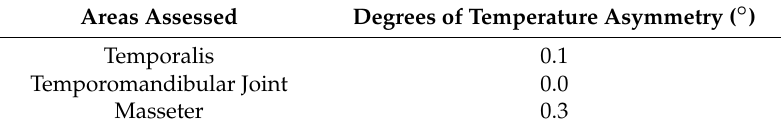
Table 2. Infrared imaging values of the thermic difference between left- and right-side at the end of the treatment. Areas Assessed Degrees of Temperature Asymmetry ( ° ) Temporalis 0.1 Temporomandibular Joint 0.0 Masseter 0.3